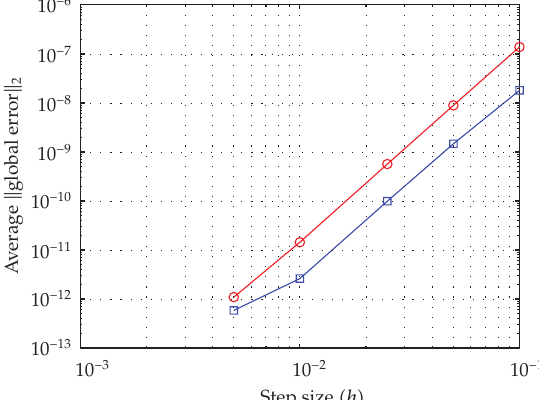
Figure 12: Comparison of the accuracy of the ARK4 (cid:4) blue (cid:5) and TSRK4 (cid:4) red (cid:5) methods in solving IVP-2.